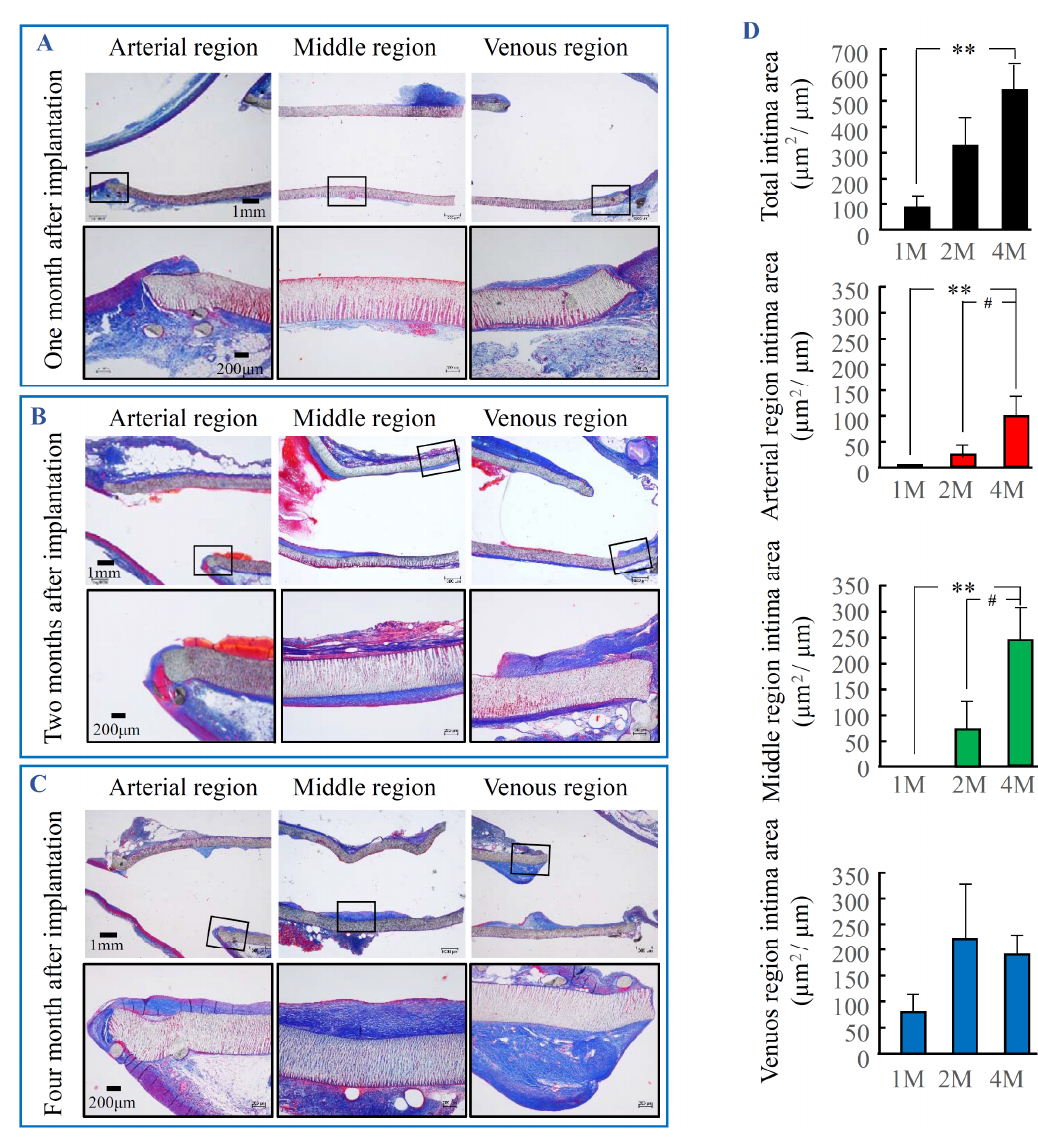
Figure 1. Azan–Mallory staining and the estimated intima areas after PTFE graft implantation. ( A – C ): Intimal formation 1, 2, and 4 months after PTFE graft implantation. Graft samples were cut along a lengthwise axis so that sections included both the native artery and vein for histological examination. The black frame of bottom pictures (A, B, C) are the extended image of the black boxes in the upper pictures. ( D ) Time-dependent changes of intima areas calculated by a computerized morphometry system. Each bar represents the mean ± S.E.M. of six grafts. ** p < 0.01 vs 1 M; # p < 0.05 vs 2 M.